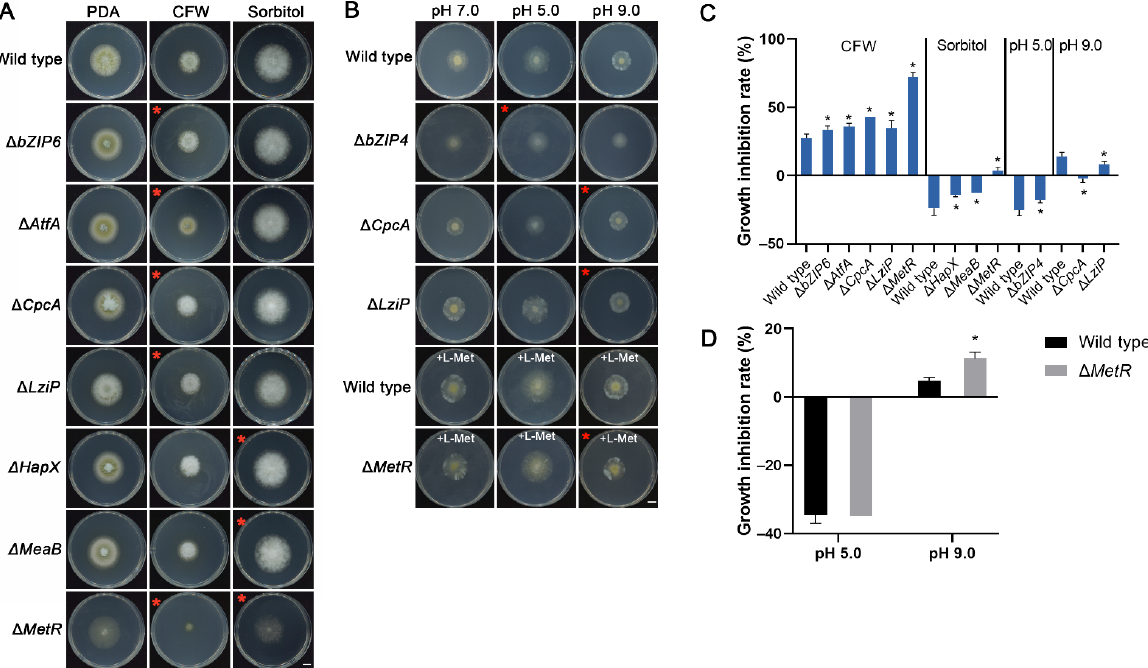
Figure 9. Effects of cell wall stress, osmotic stress, and acid and alkali stress on the growth of Aspergillus flavus strains. Mutants with significant differences are shown here. The rate of inhibition of the others is shown in Table S3. ( A ) Colonies of the mutants subjected to CFW and sorbitol stress. The mutant strains were inoculated on PDA supplemented with 400 μ g/mL CFW for cell wall stress and 1.5 mM sorbitol for osmotic stress for 3 days at 30 °C. Bar = 1 cm. ( B ) Colonies of mutants under acid and alkali stress. bZIPs mutant strains that were inoculated on MM with pH 5.0 and pH 9.0 for 3 days at 30 °C, except that Δ MetR was inoculated on MM supplemented with 5 mM L-methionine (L-Met). pH 7.0 was used as the control. A red star indicates the mutant phenotype. Bar = 1 cm. ( C ) Growth inhibition rate of mutants under stresses. The rate of inhibition of mycelial growth was calculated by measuring the diameter of fungal colonies and normalized to the growth of control, respectively. ( D ) Growth inhibition rate of Δ MetR . The error bars represent the SD. * p < 0.05, signif- icant difference from the wild-type group as estimated by a Dunnett test. CFW, Calcofluor white. MM, minimal media; PDA, potato extract agar; SD, standard deviation.